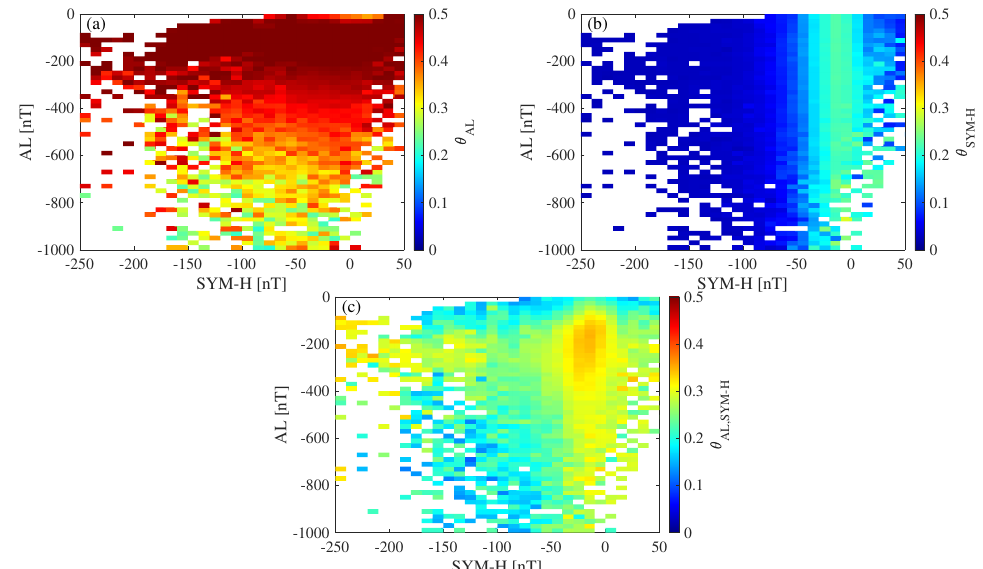
Figure 6. Instantaneous stability θ as a function of the values of both geomagnetic indices. Panels ( a , b ) refer to the individual time series, while panel ( c ) corresponds to the joint observations. The color map is saturated above 0.5 for visualization